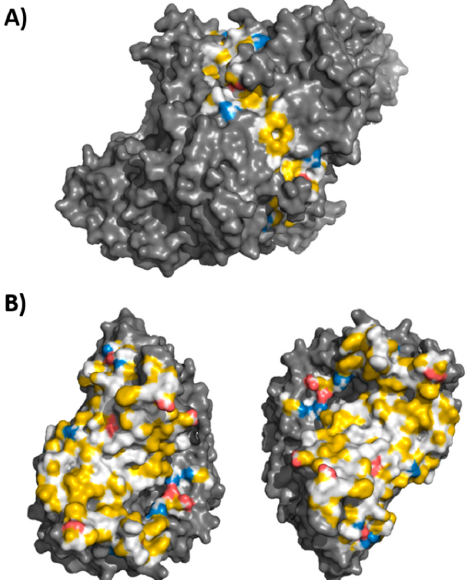
Figure 4. Active ALS from wild poinsettia showing ( A ) the ensemble dimer and ( B ) the interfaces of each monomer. Inspection of the interface revealed large hydrophobic domains stabilized by distributed electrostatic anchors. Residues involved in the interaction were colored according to each residue properties and the others were colored 50%